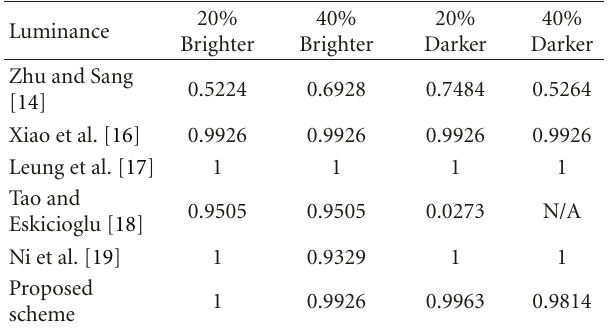
Table 8: Experiment results comparison under luminance attacks (NC values).